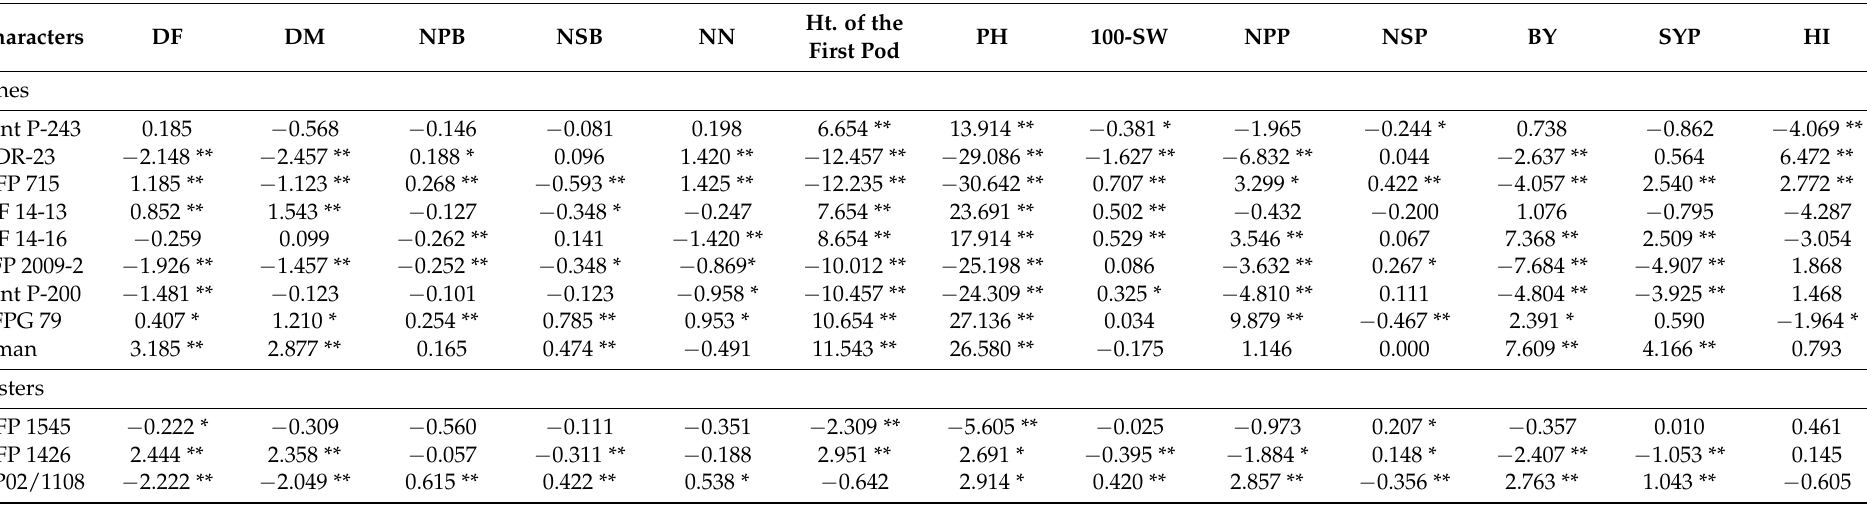
Table 3. GCA effects of lines and testers for different characters in field